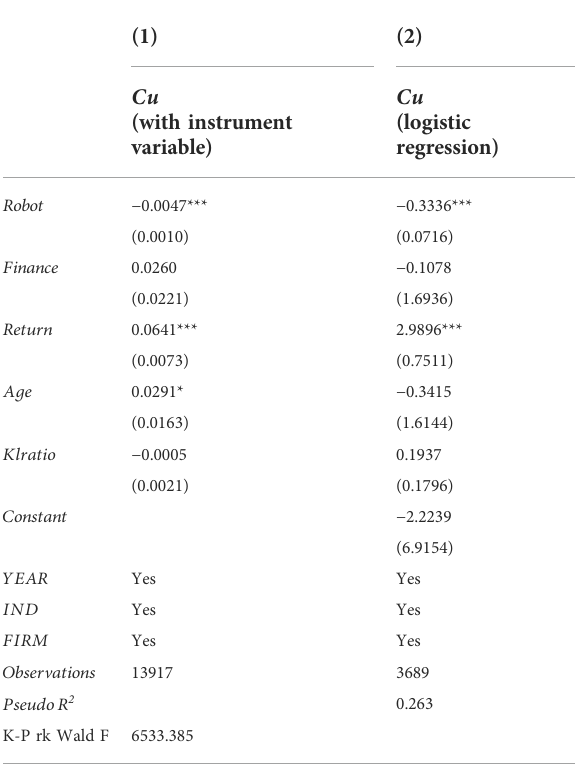
TABLE 5 Results of robustness